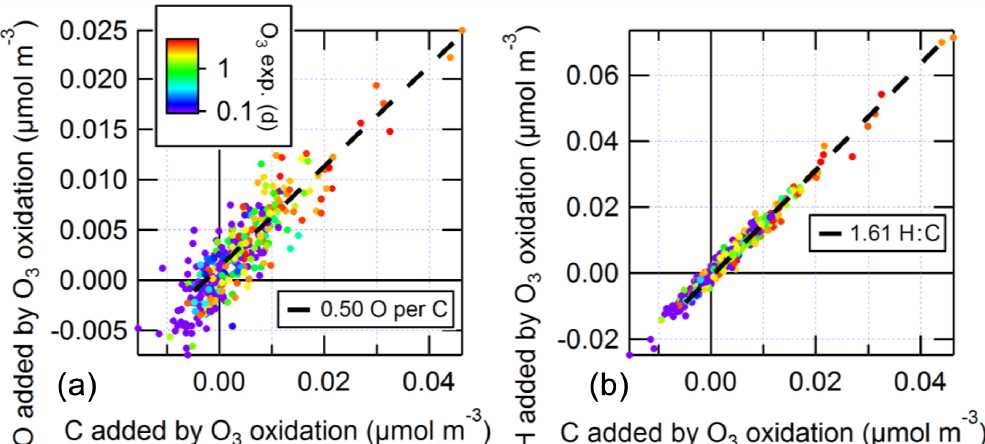
Figure 9. Scatter plots of µmolm − 3 O andµmolm − 3 H added per µmolm − 3 C added from O 3 oxidation of ambient air in the OFR. Data are colored by eq. d of O 3 exposure. The slopes show that the atomic O:C (H:C) ratio of the SOA mass formed was 0.50 (1.61). The slopes did not change with increasing photochemical